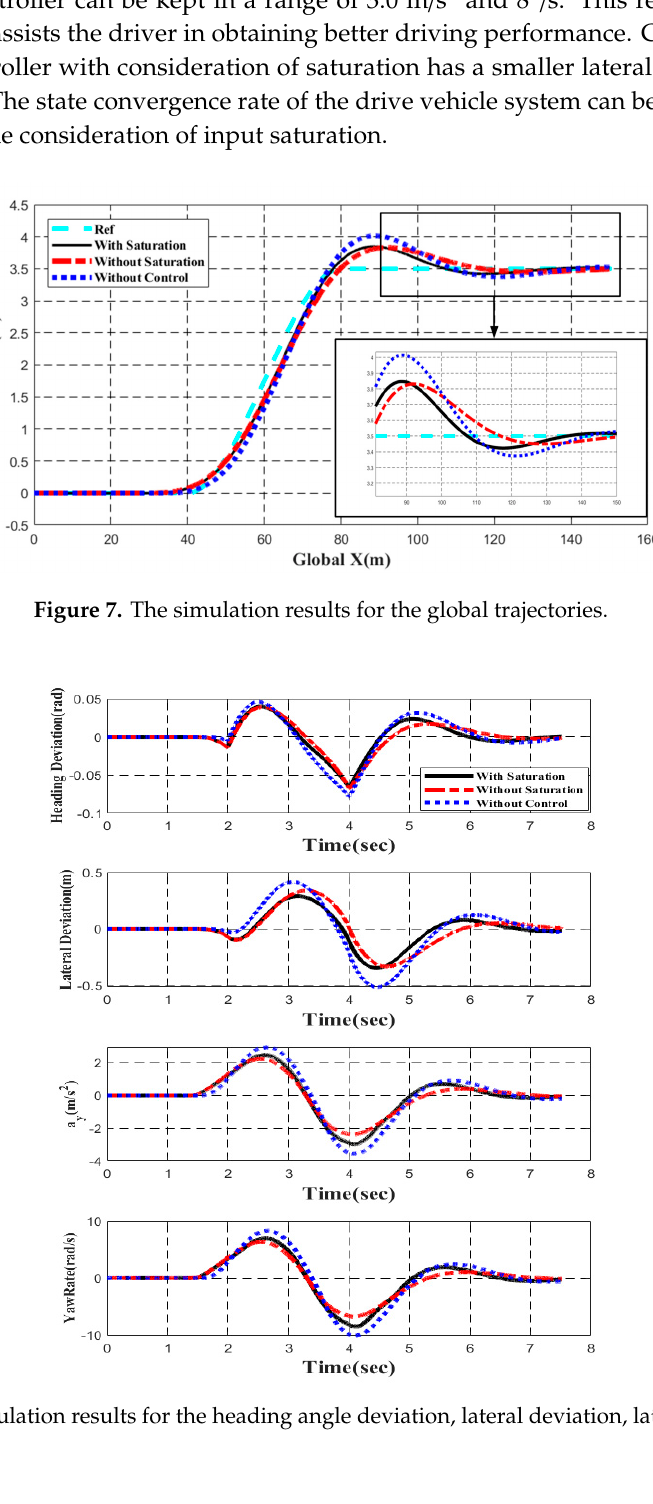
and yaw Figure 8. The simulation results for the heading angle deviation, lateral deviation, lateral acceleration, and yaw rate.